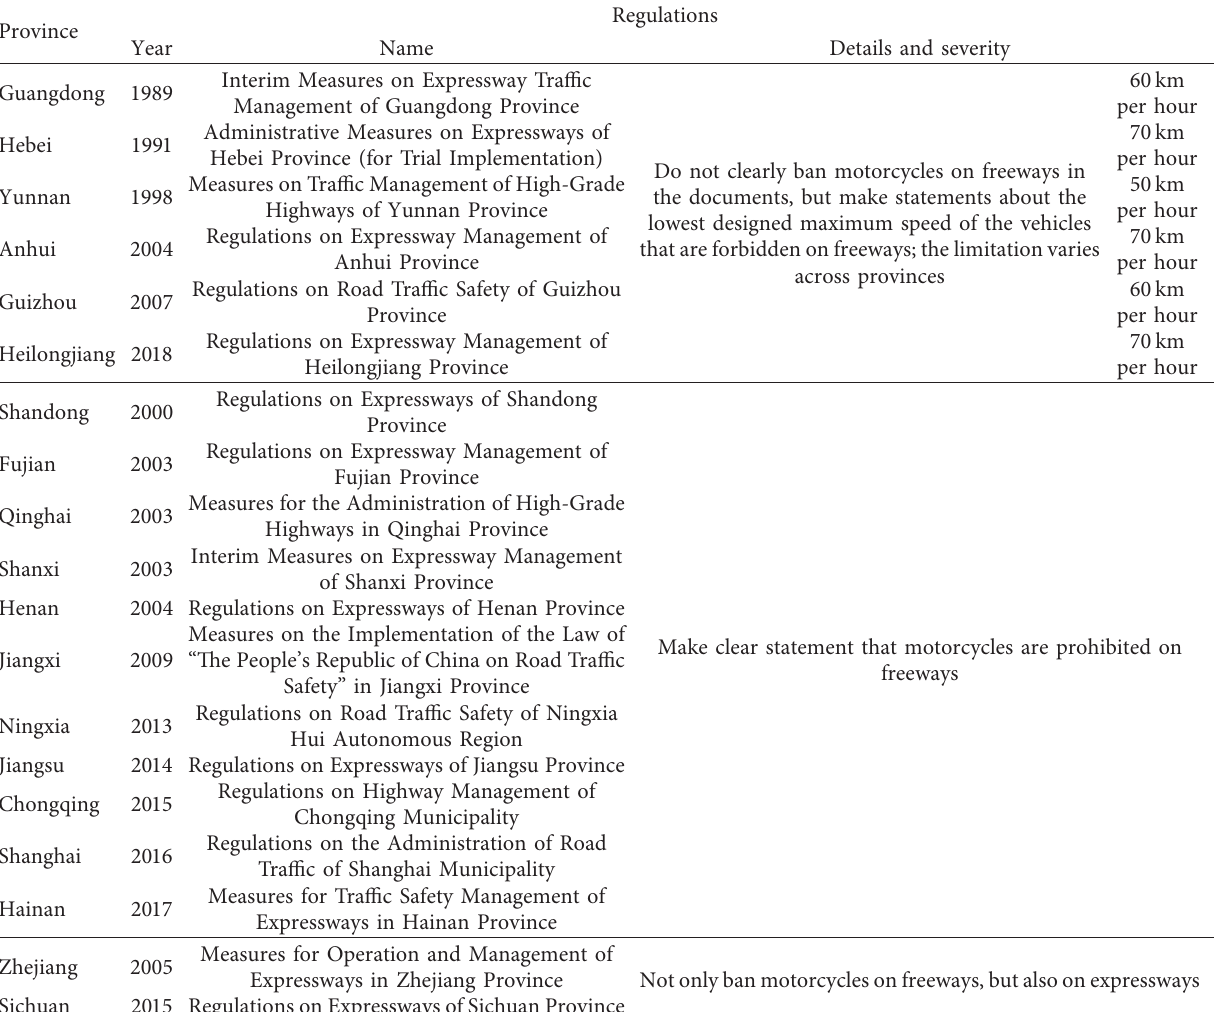
Figure 1: The trends of motorcycle-related traffic accidents. (a) Proportions of motorcycle-related. (b) Comparation between motorcycle- related and traffic accident average death rate per 100 accidents. Table 1: Different provinces’ regulations concerning motorcycles on